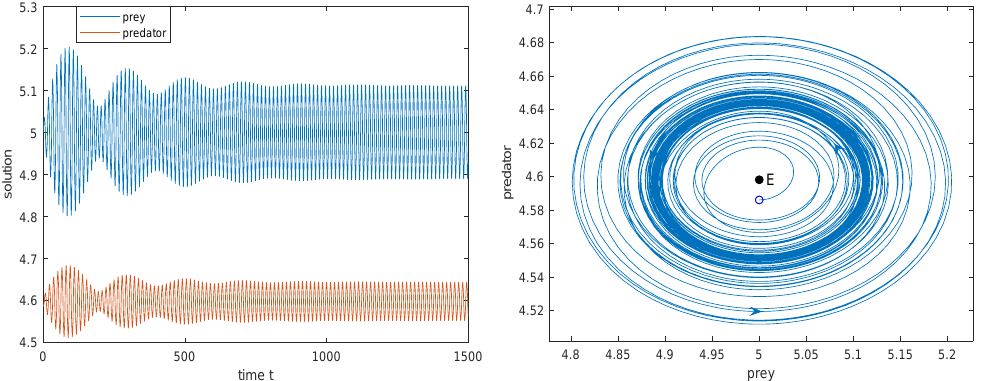
= 14.6586, the supercritical Hopf bifurcation occurs at E in . Initial value: ( φ 1 , φ 2 ) = ( 5,4.586 ) Figure 11. τ = τ + 1